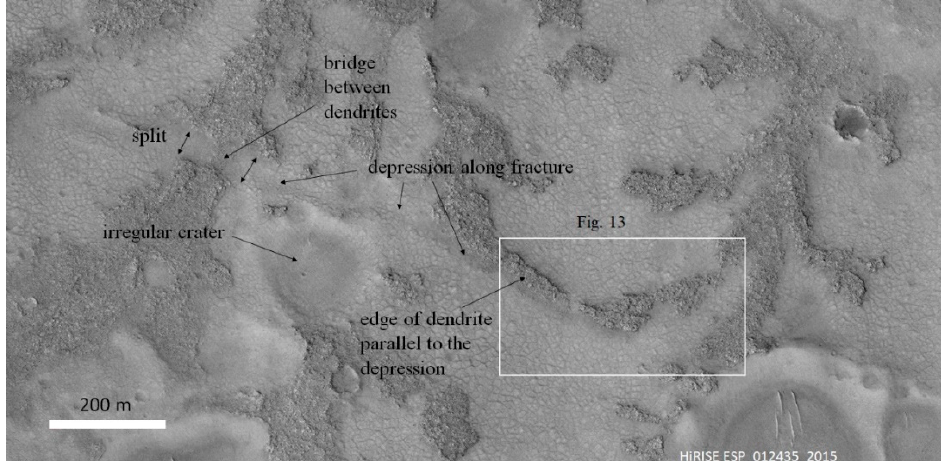
Figure 12. HiRISE detail of a 400 m long dendrite branch parallel to a shallow depression probably linked to an earlier fracture (“edge of dendrite parallel to the depression”). To the left, a bridge between dendrites may have been formed after split of the pre-existing dendrite by the fracture, as indicated in the figure. One of the many irregular (i.e., not perfectly circular) craters, probably created when the lake was still present, is indicated with an arrow. It is suggested that the impact that produced the crater shattered a portion of the dendrites. Note the intact dendrite, especially in the southern end of the impact crater. Two remnants of the dendrites are also visible on the upper left and right of the crater. The area shown here is marked in Figure 10.